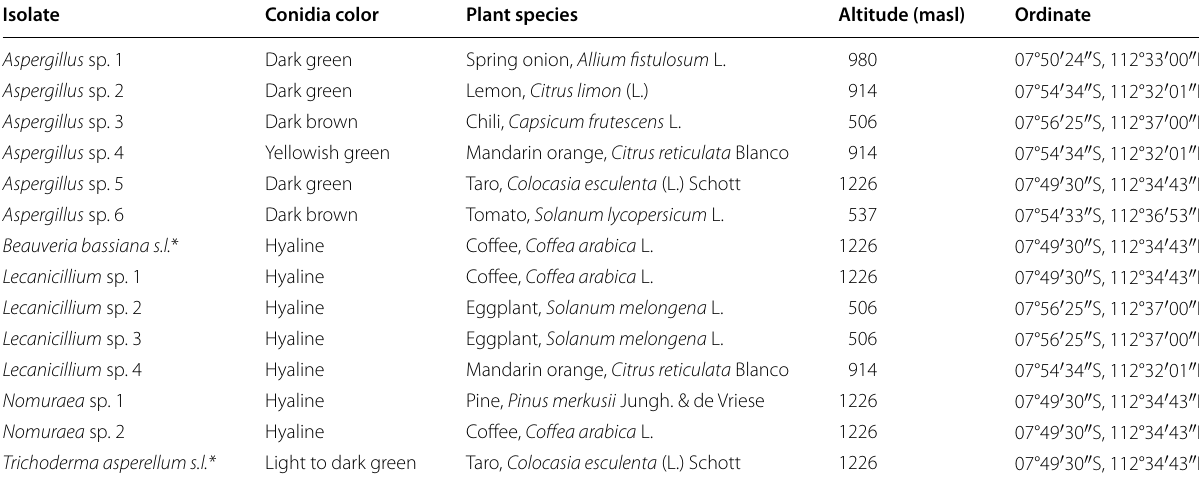
Asterisk (*) indicates that the isolate was further identified based on its morphological characteristics and defined sensu lato (abbreviation “ s.l. ”)